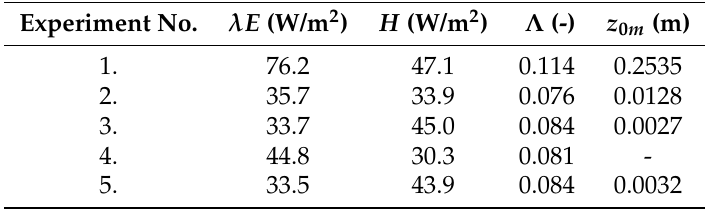
Figure 12. Scatter plots of measured and estimated latent heat flux for ( a ) experiment 1, ( b ) experiment 2, ( c ) experiment 3, ( d ) experiment 4, ( e ) experiment 5. Table 6. RMSE of simulated heat flux densities and associated roughness length at the AMS scale. Experiment